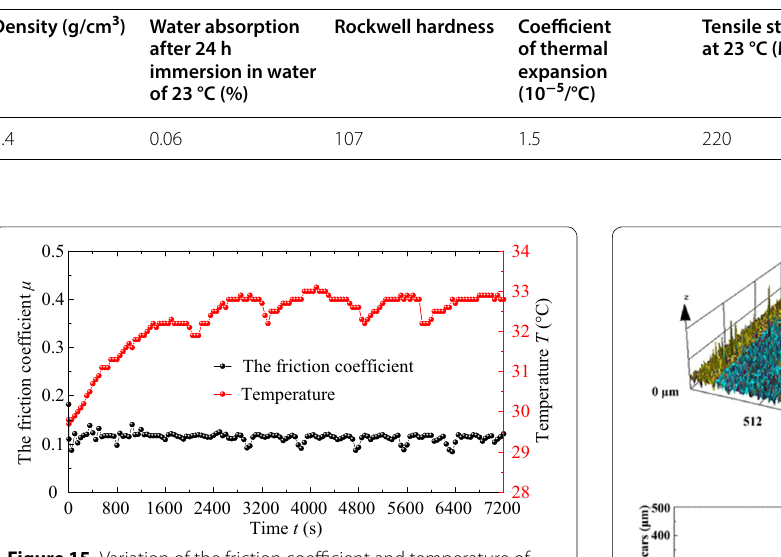
Figure 15 Variation of the friction coefficient and temperature of port plate pairs with test time